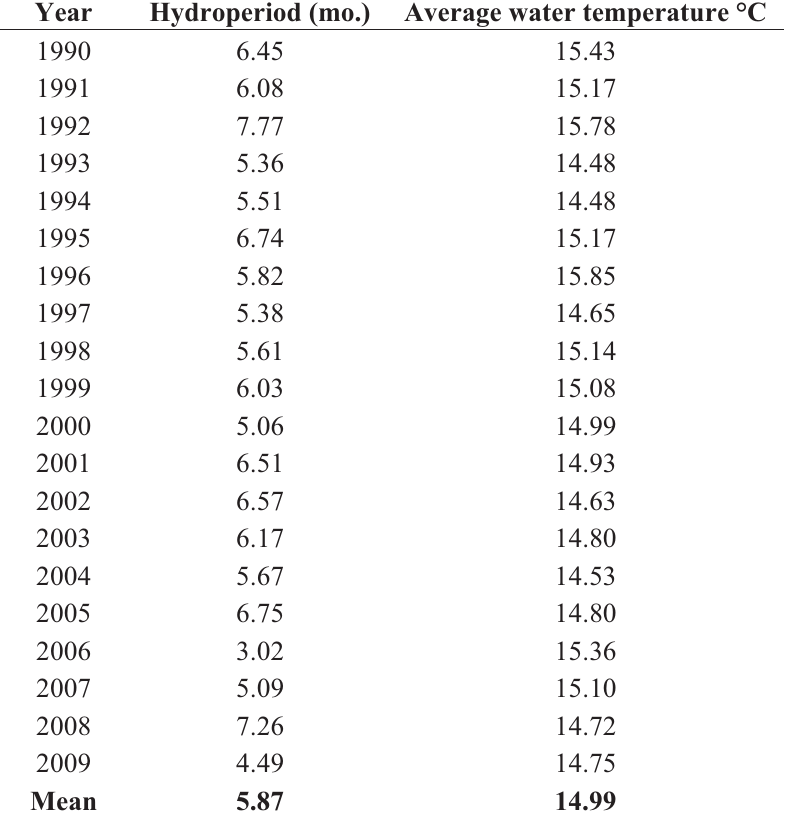
Table 1. Summary of the hydroperiod and water temperatures predicted by WET-R for the years 1990–2009 at Ellen Brook Nature